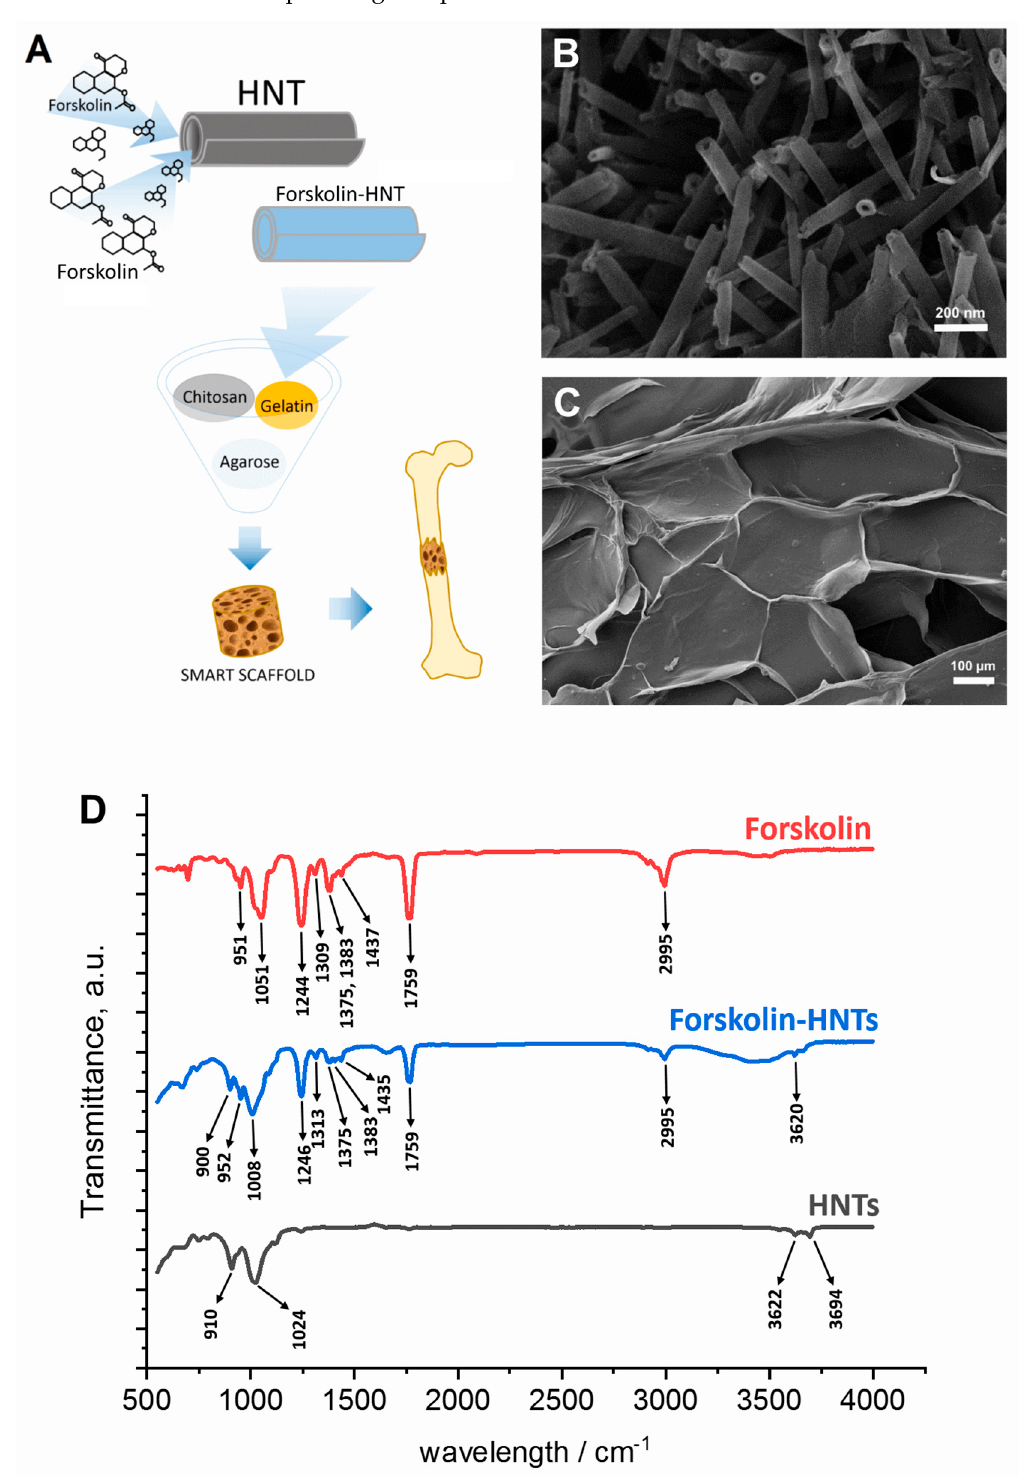
Figure 1. ( A ) Scheme demonstrating the forskolin-doped polymer scaffold fabrication ( A ) and its characteristics: ( B , C )— SEM images of HNTs and scaffold surface, respectively, ( D )—FT-IR spectrum of forskolin loaded HNTs. The scale bars in ( B , C ) are 200 nm and 100 μ m, respectively.